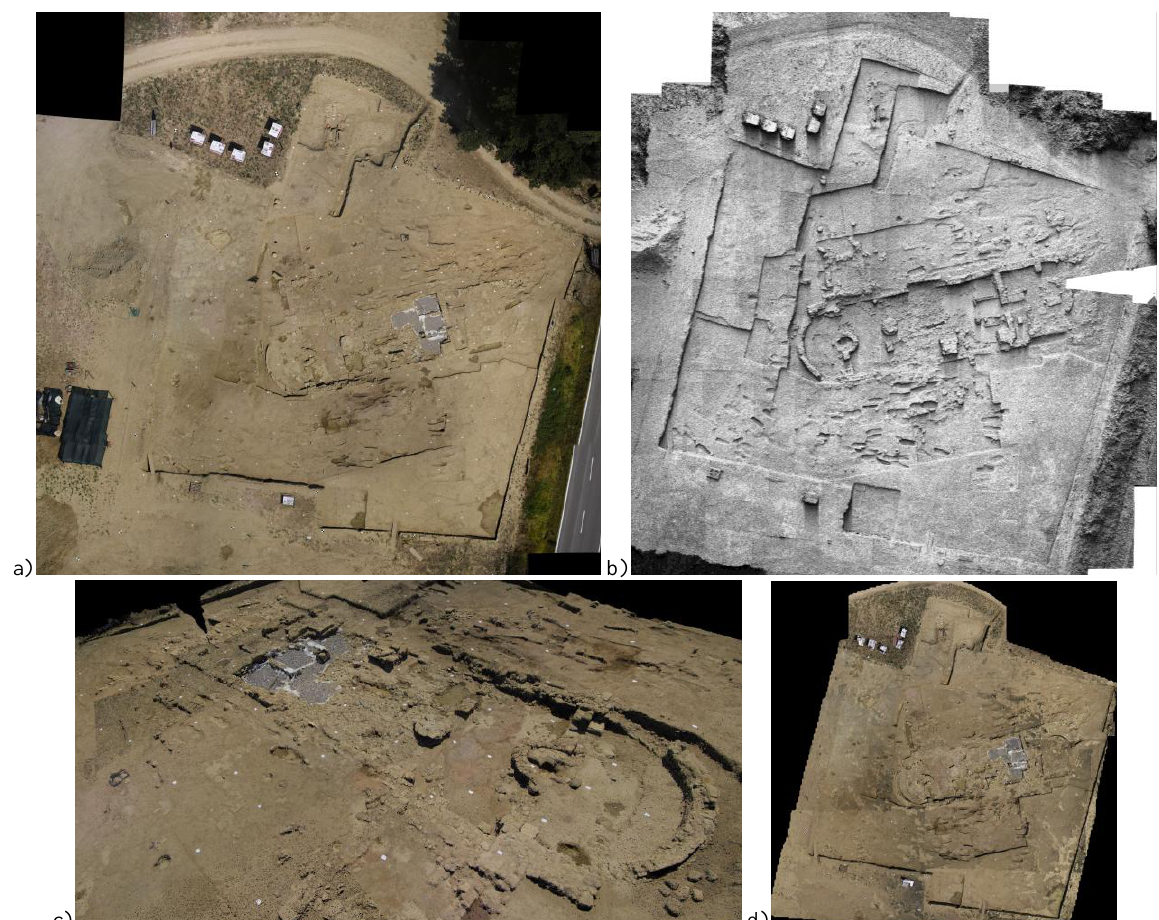
Figure 6: A mosaic over the excavation area in Pava (a), the derived DSM, shown in shaded mode (b), a closer view of the textured 3D model (c) and the produced orthoimage